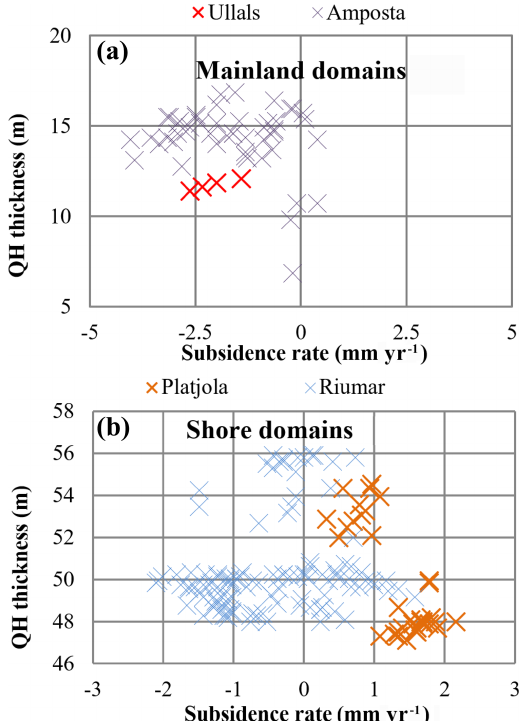
Figure 2. Comparison between sediment thickness of the Ebro delta plain and subsidence rate measured with DInSAR in Main- land (a) and Shore (b)